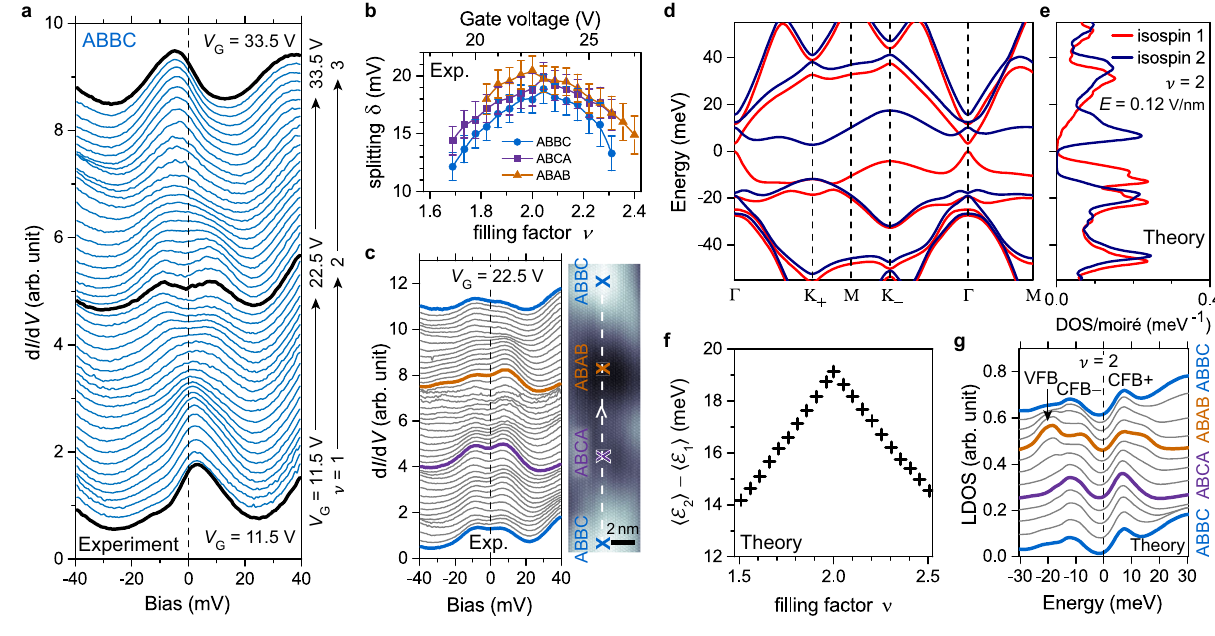
Fig. 5 Emergent correlated state at ν ≈ 2. a Gate-dependent d I /d V spectra in ABBC region for 11.5 V < V G < 33.5 V (1 < ν < 3). Spectroscopy parameters: modulation voltage V RMS = 1 mV; initial V Bias = – 100 mV, I 0 = 0.5 nA. b Magnitude of CFB energy-splitting extracted as a function of gate voltage ( fi lling factor) for three stacking regions. The error bars were estimated by combining fi tting uncertainty, fi nite temperature broadening, and an instrumental broadening of ~1 mV. c Spatially resolved d I /d V spectra measured at V G = 22.5 V ( ν = 2) along the white dashed line in the topographic image (which goes through all three tDBLG stacking regions). Scanning parameters: V Bias = – 100 mV, I 0 = 0.1 nA. Spectroscopy parameters: modulation voltage V = 1 mV; initial V = – 100 mV, I = 0.5 nA. d Hartree-Fock band structure of tDBLG and e the corresponding isospin-resolved DOS for an isospin- RMS Bias 0 polarized solution at ν = 2 ( E = 0.12 V/nm, ε eff = 14, d S = 50 nm). For clarity only bands from a single valley are shown. f Energy offset (i.e., splitting) between the isospin sub-bands averaged over the mini-Brillouin zone as a function of fi lling factor for 1.5 < ν < 2.5. g Calculated Hartree-Fock LDOS for ν = 2 at different positions across the moiré unit cell corresponding to white dashed line in c . CFB conduction fl at band, VFB valence fl at